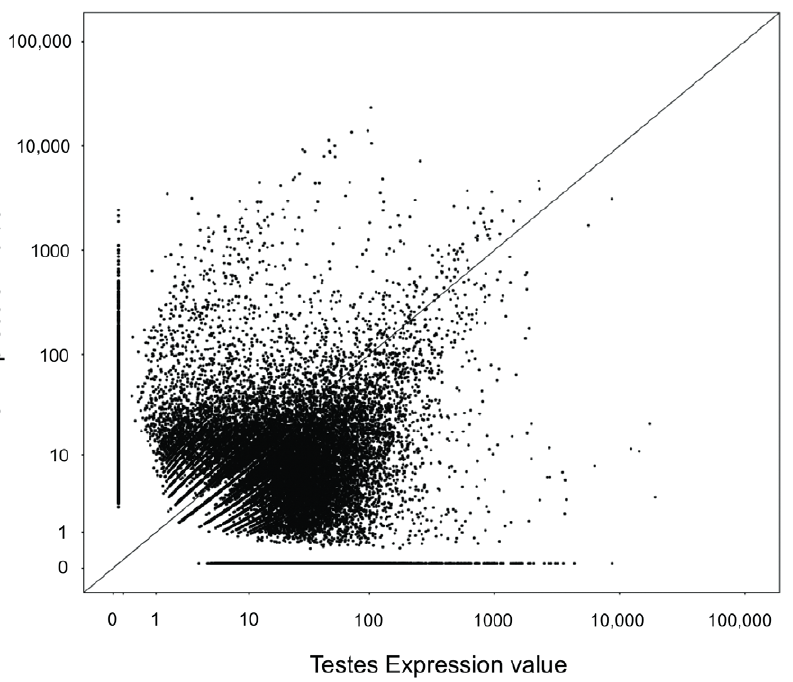
Figure 3. Relative expression (RPKM) of 454 sequenced transcriptome across liver and gonad tissue. Diagonal line represents equal expression in both tissue types. Note both axes are on the logarithmic scale.